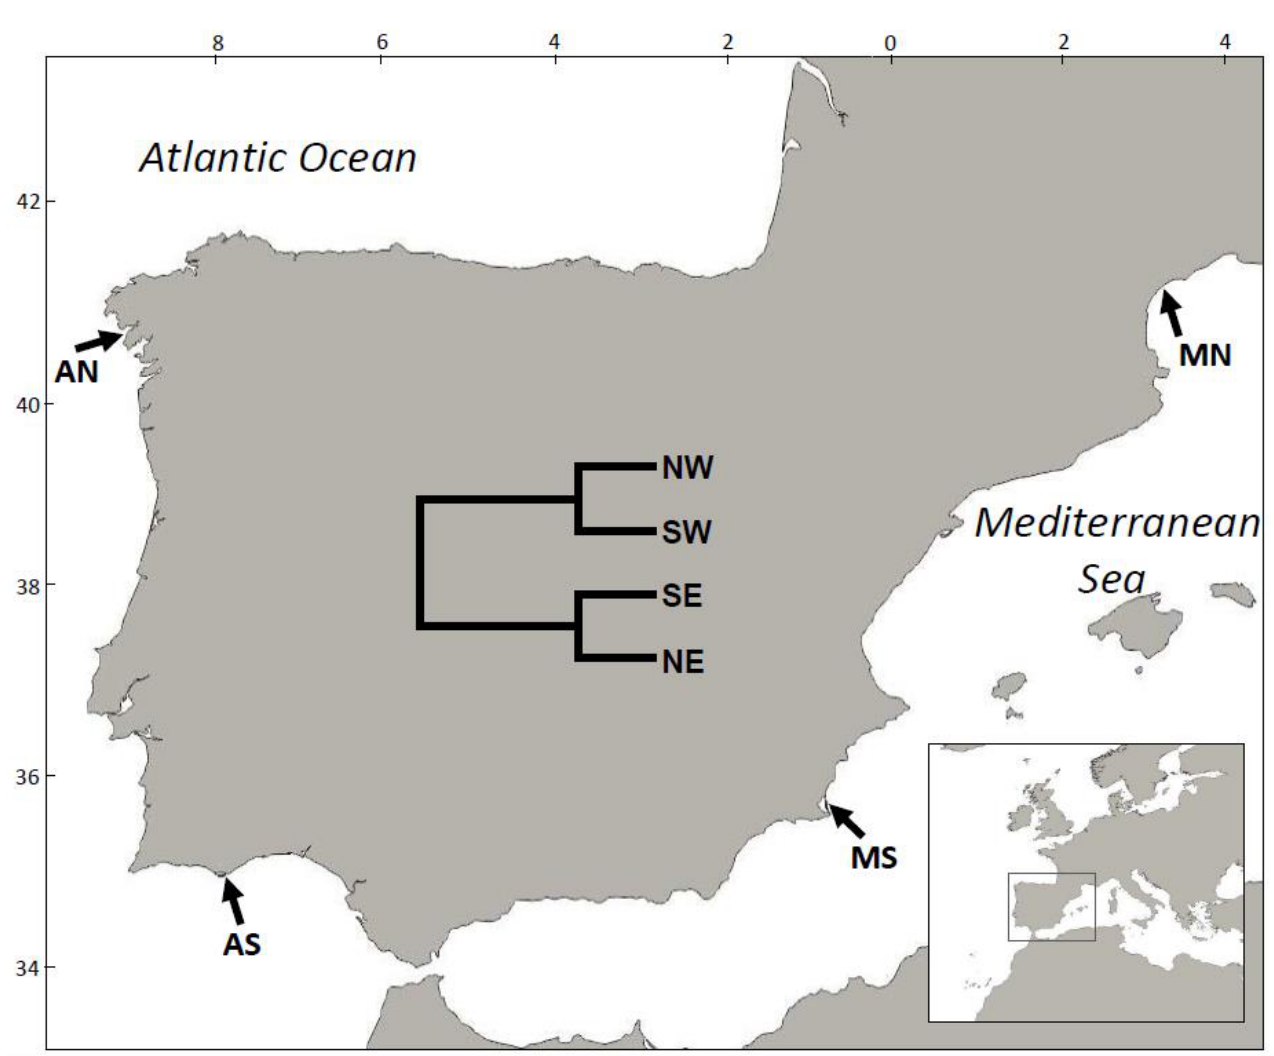
Figure 1. Map showing the localities sampled and the NJ tree (inset) based on F ST values computed from 6 intron RFLP genetic markers. AN: Ría de Noia estuary (Spain); AS: Ria Formosa lagoon (Portugal); MS: Mar Menor lagoon (Spain); MN: Thau lagoon (France). On February 2012, 15 clams from the AN, MN, and MS sites were transported live in a cool container to the Ramalhete Marine Station at the University of Algarve near Faro (Portugal). Upon arrival, the clams were placed in an outdoor 300 L PVC tank and pro- one week before in the nearby shellfish beds of Ria Formosa were incorporated to the